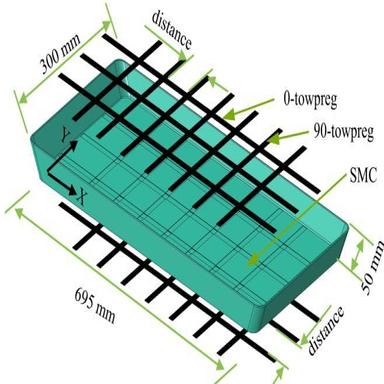
Schematic illustration of the towpreg-based grid-like structure and the researched 3D part geometry.